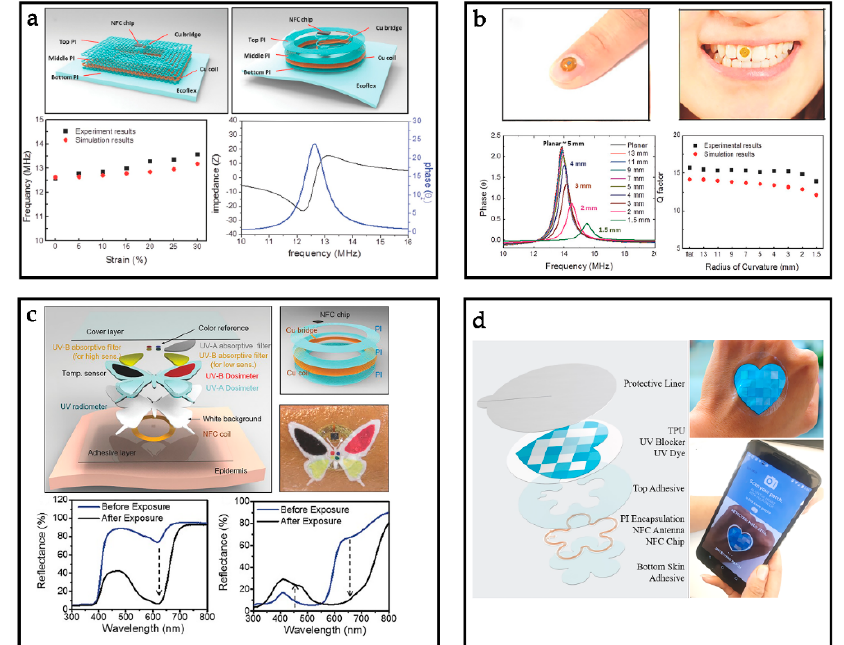
Figure 3. Representative examples of biophysical signals monitoring. ( a ) Exploded-view schematic illustrations of each layer of the skin-mounted NFC devices with rectangular coil. Reprinted with permission from ref. [83]. ( b ) Picture of a device on a tooth and fingernail. Reprinted with permission from ref. [51]. ( c ) Wearable NFC sensors attached onto teeth and fingers. Reprinted with permission from ref. [84]. ( d ) Construction of the UV sensor. Reprinted with permission from ref. [75].